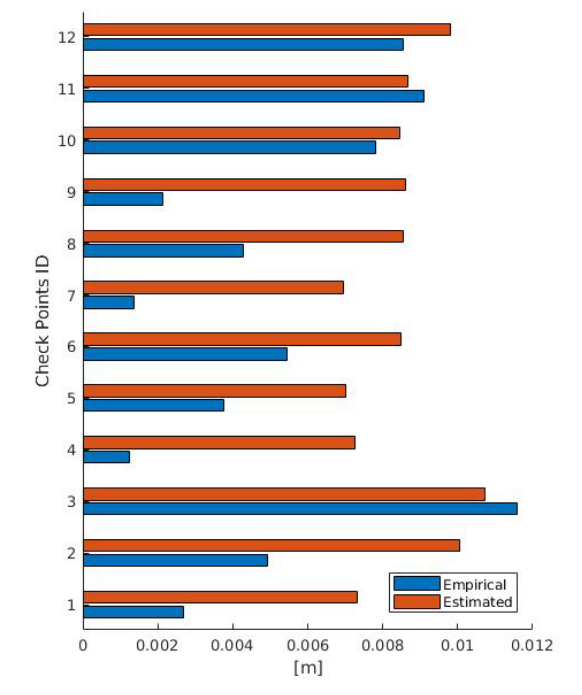
Figure 9. Empirical deviation and theoretical a priori rms